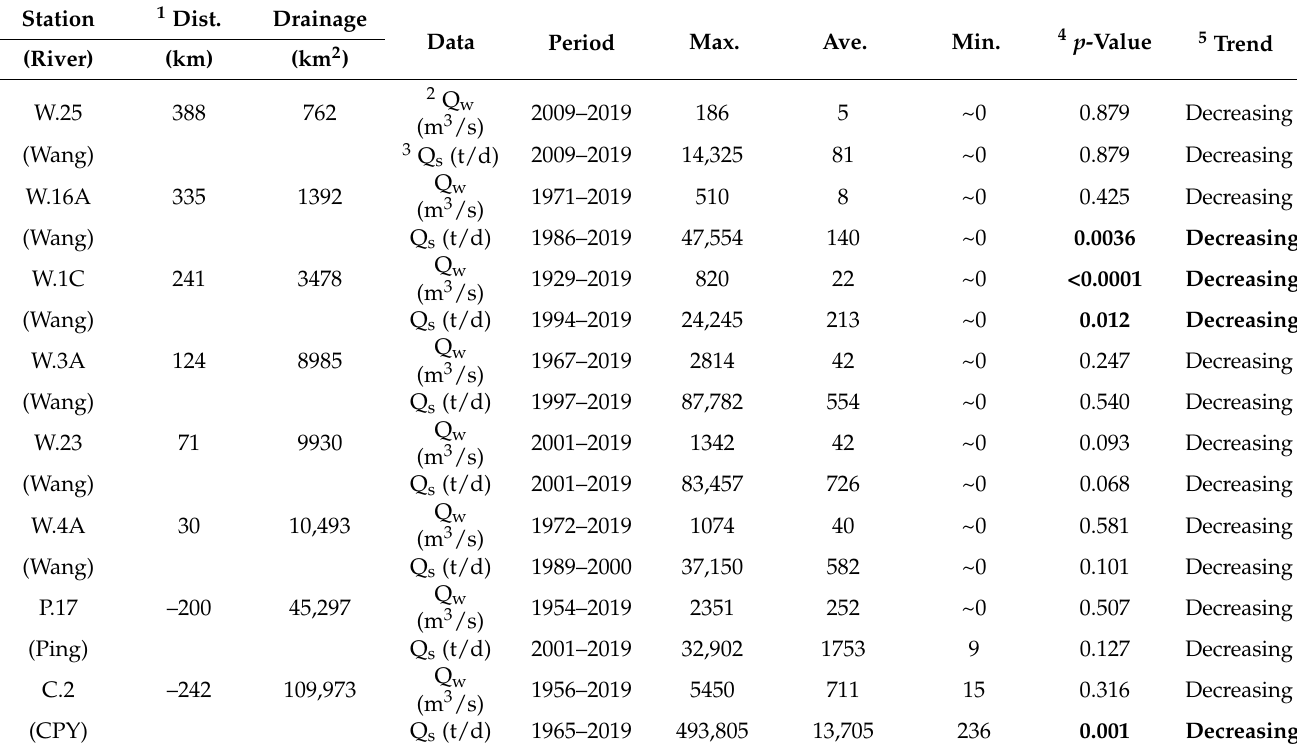
Table 1. Summary of available data and statistics of streamflow and suspended sediment at RID hydrological stations on the Wang River, Ping River, and Chao Phraya River (CPR) (significance accepted at p -value < 0.05).